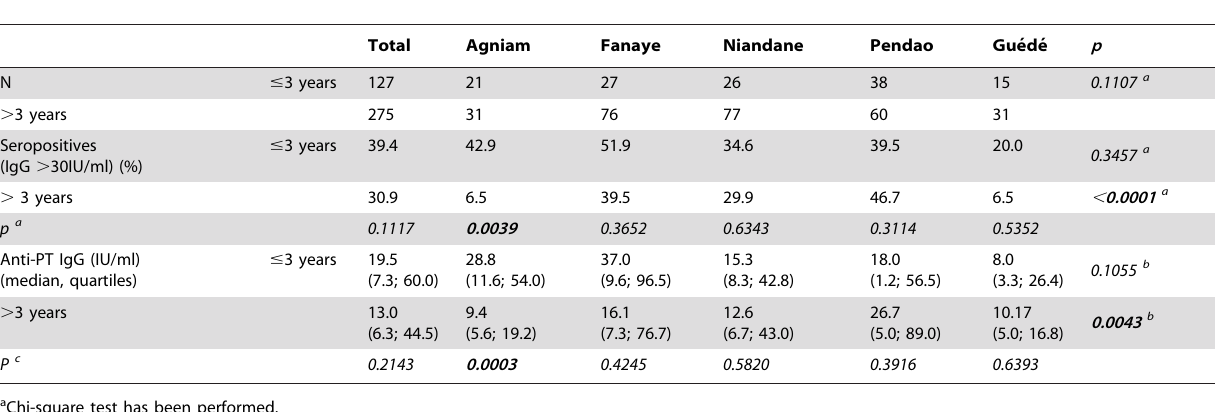
Table 4. Anti-PT seroprevalence at T1 in all villages according to age category.